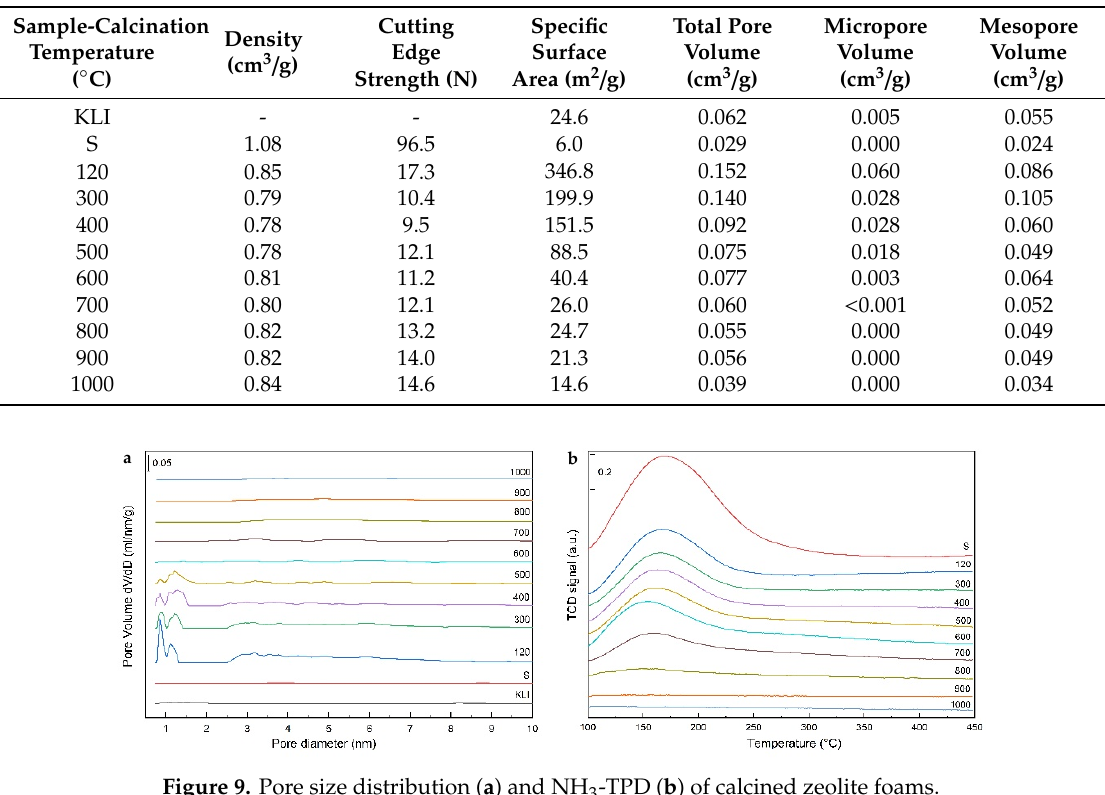
Table 6. Mechanical and textural properties of calcined zeolite foam pellets.